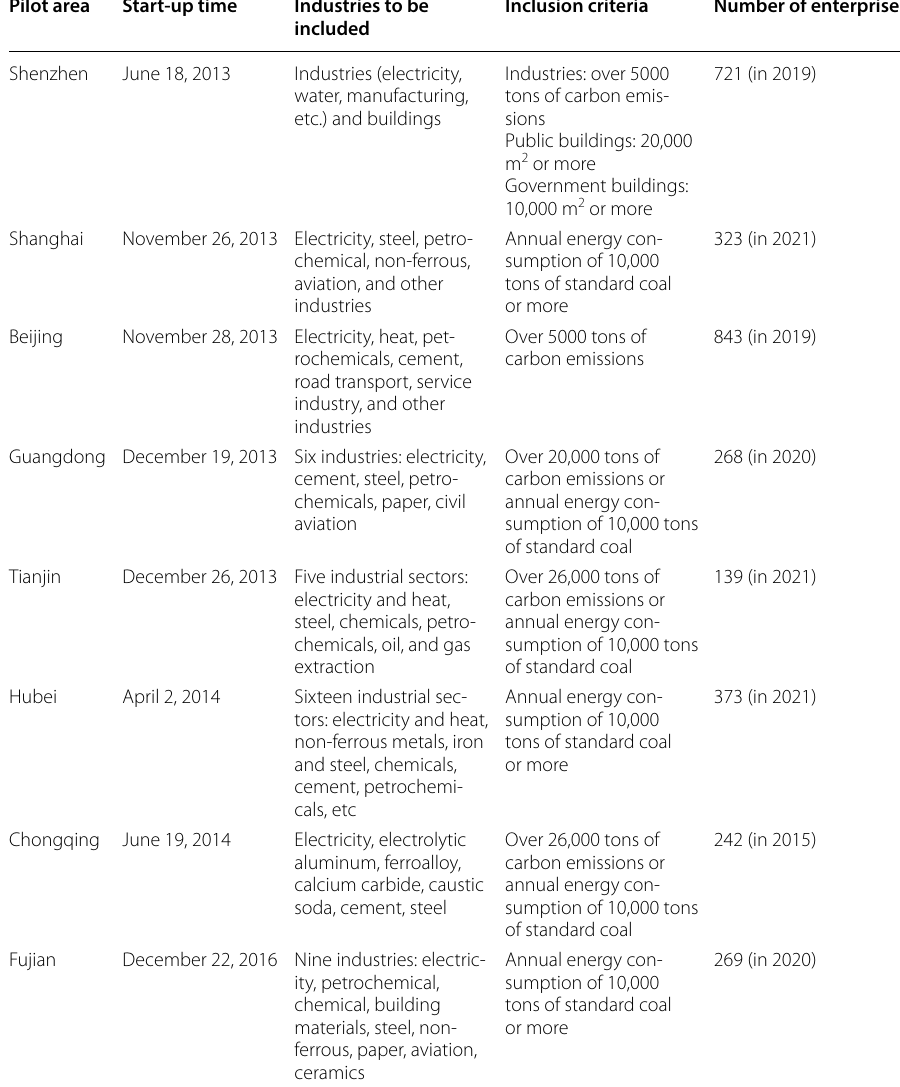
Table 1 Chinese carbon trading market inclusion criteria Pilot